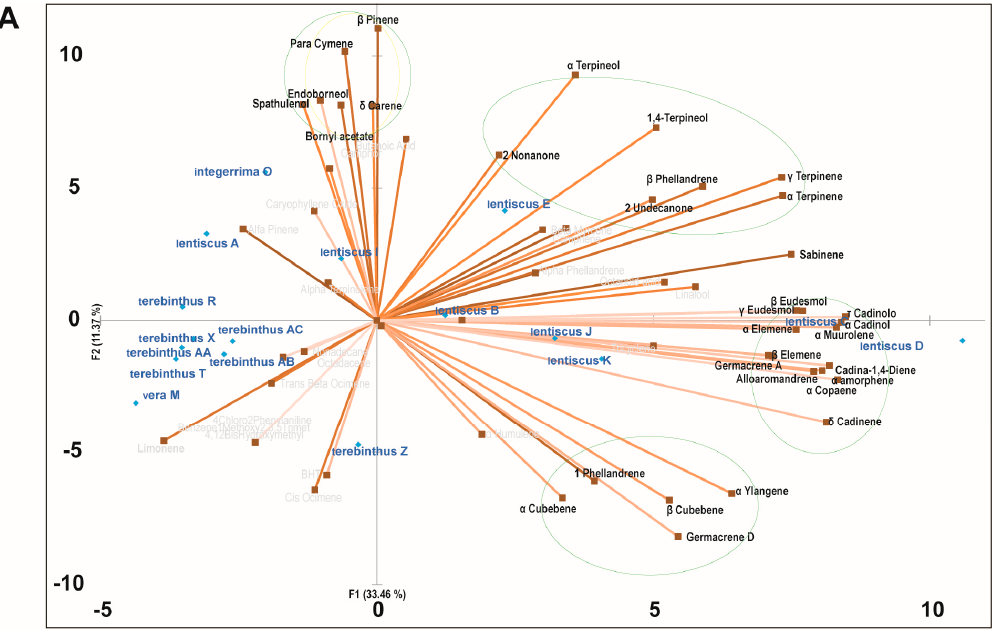
Figure 3. Cont . Figure 3.